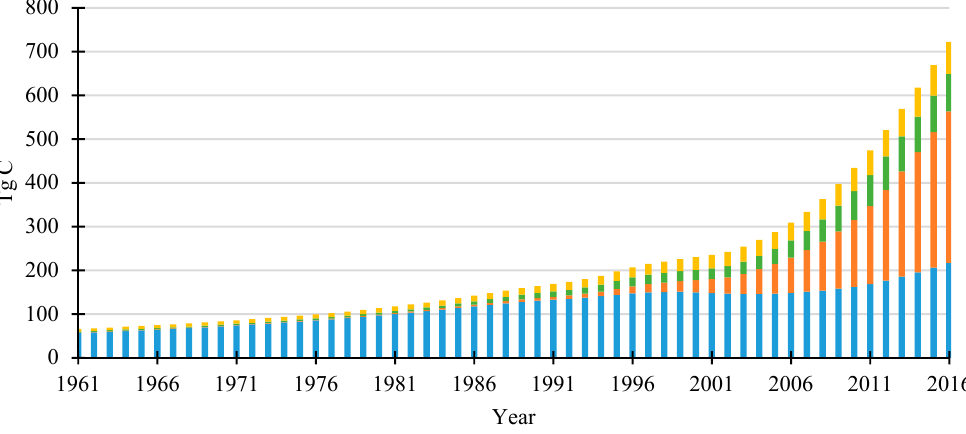
Figure 1. Carbon stored in HWP in China by different categories.